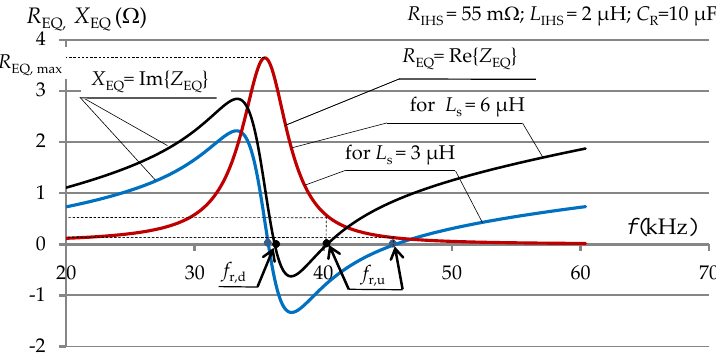
Figure 2. The waveforms of the equivalent resistance and reactance of the LLC system as a function of frequency.